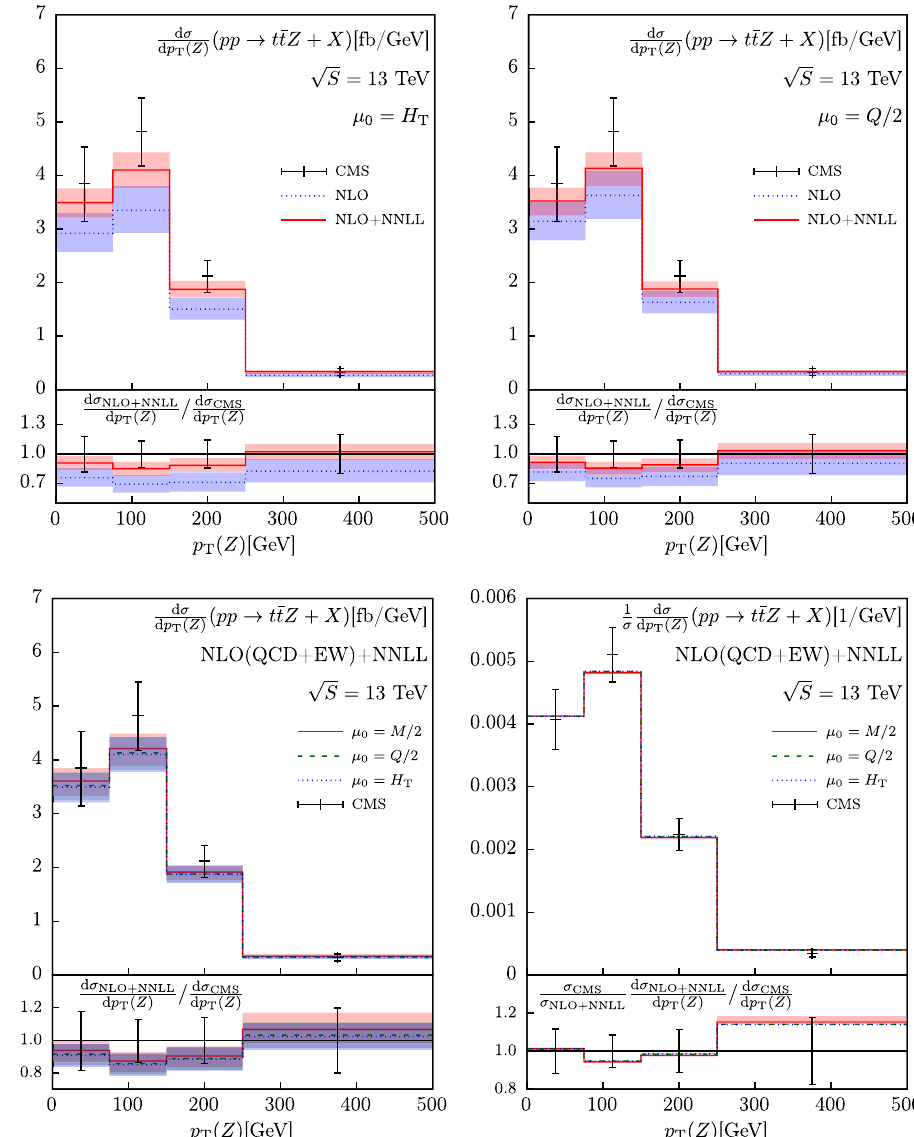
angle φ and rapidity y differences: φ( t ) − φ( ¯ t ) , φ( t ) − φ( B ) , y ( t ) − y ( ¯ t ) and y ( t ) − y ( B ) for all the considered bosons.